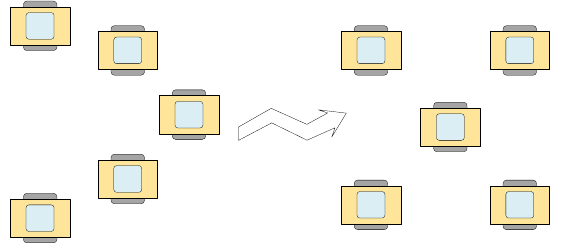
Figure 2. Schematic diagram of geometric change of the formation.